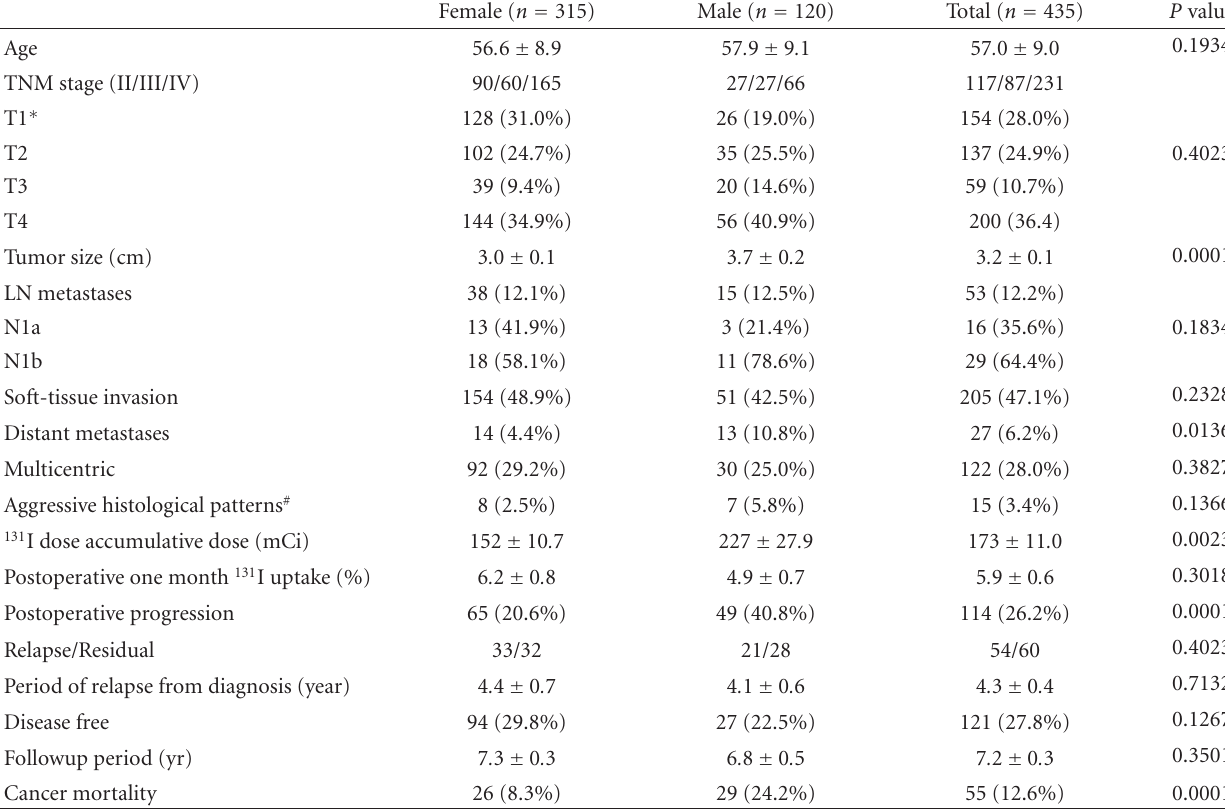
Table 1: Clinical features of papillary thyroid carcinoma by gender.